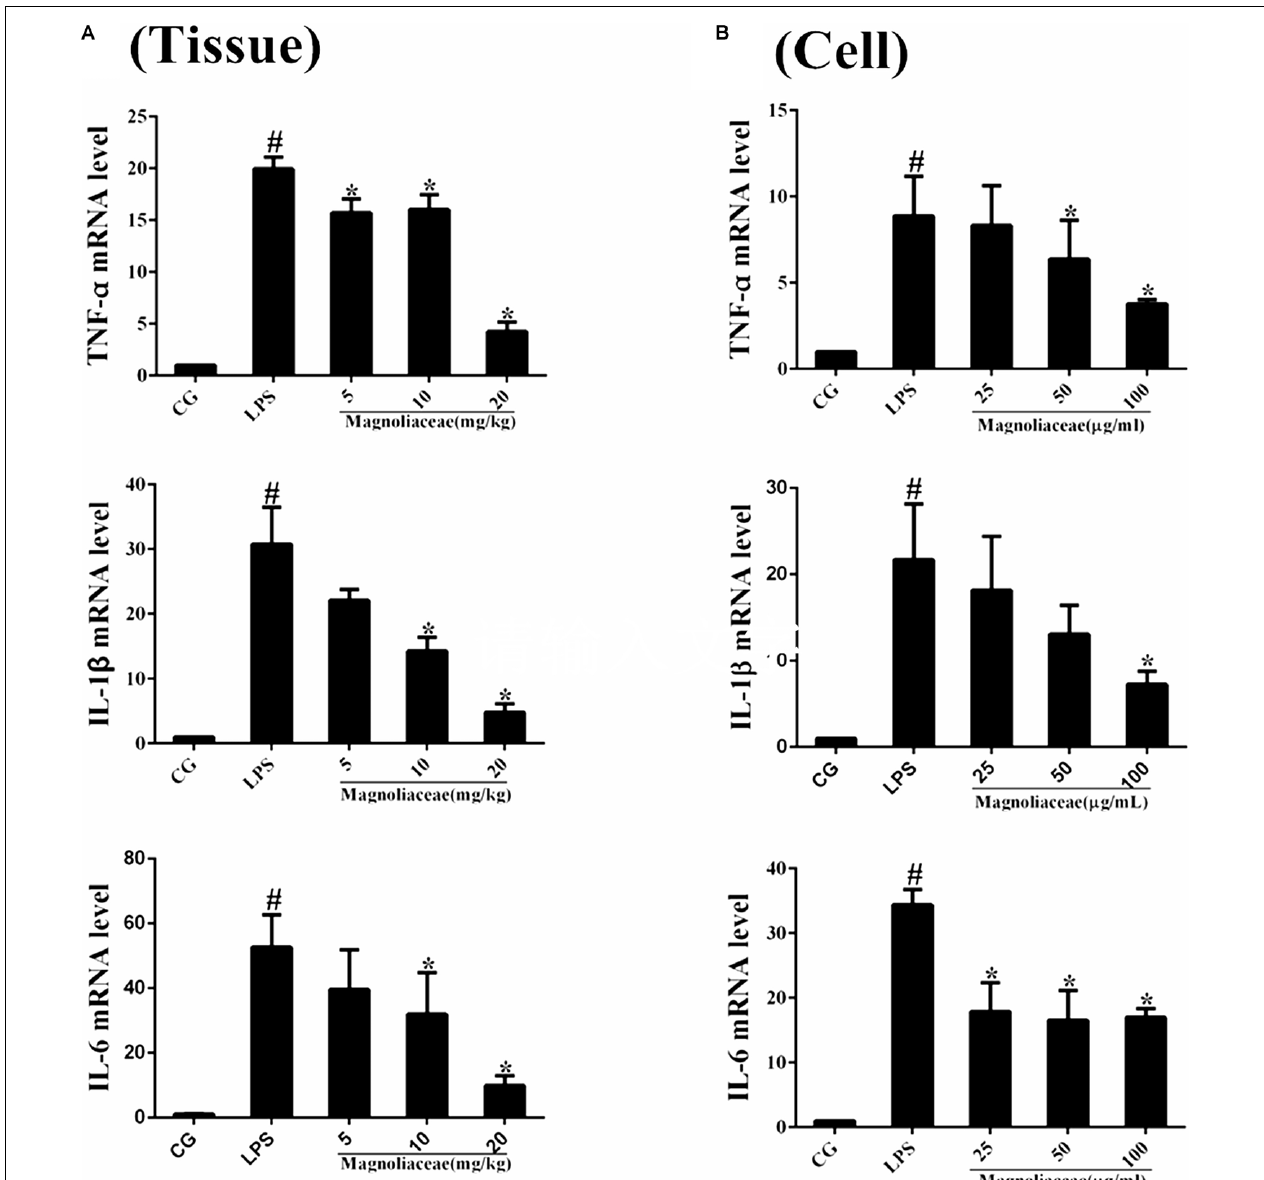
FIGURE 4 | Effects of magnoflorine on the production of cytokines. (A) The expression of TNF- α , IL-1 β , and IL-6 mRNA in lung tissues were measured by qPCR. (B) The expression of TNF- α , IL-1 β , and IL-6 mRNA in RAW264.7cells were measured by qPCR. GAPDH was used as a control. CG is the control group. LPS is the LPS-stimulated group. The data are presented as the mean ± S.E.M. of three independent experiments. ANOVA, p < 0.0001, post hoc # p < 0.05 vs. control group, ∗ p < 0.05 vs. LPS group.